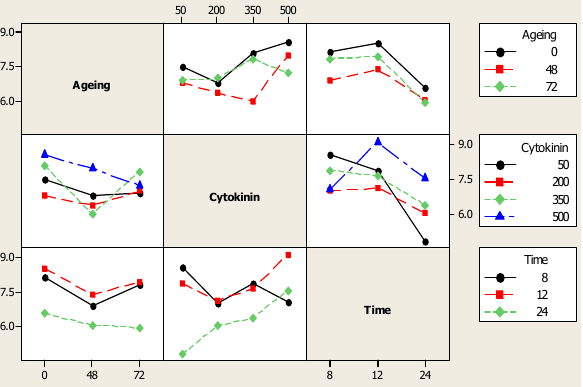
Fig. 3. Interaction plot of mean daily germination under hormone seed priming and ageing